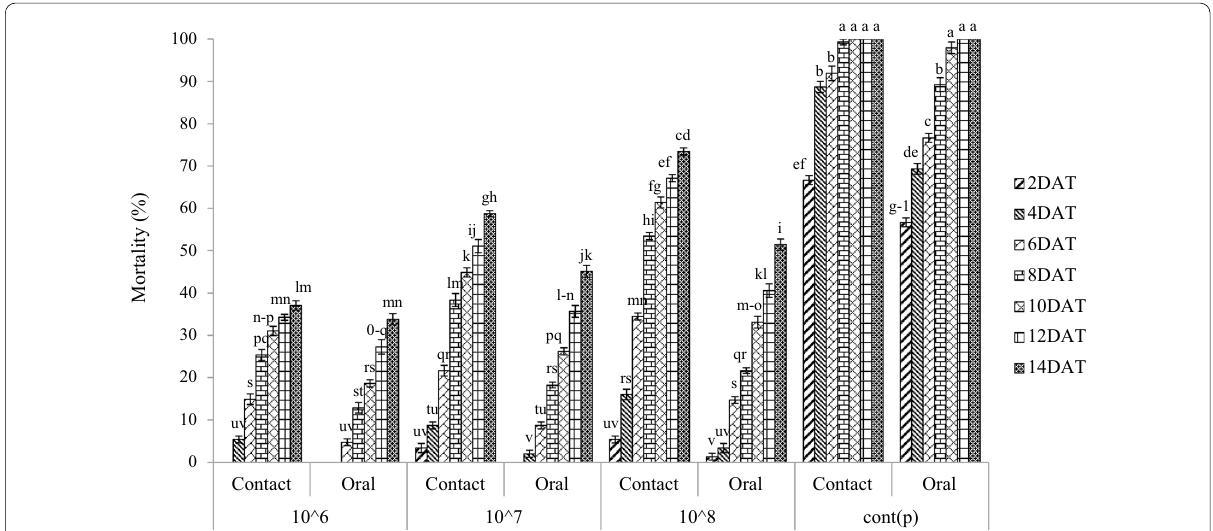
Fig. 3 Contact and oral pathogenicity of Beauveria bassiana against Bactrocera. cucurbitae at three concentrations (10 6 , 10 7 and 10 8 CFU/ml)